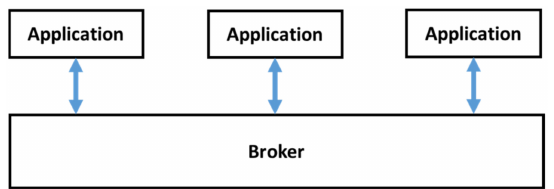
Figure 11. Messaging integration